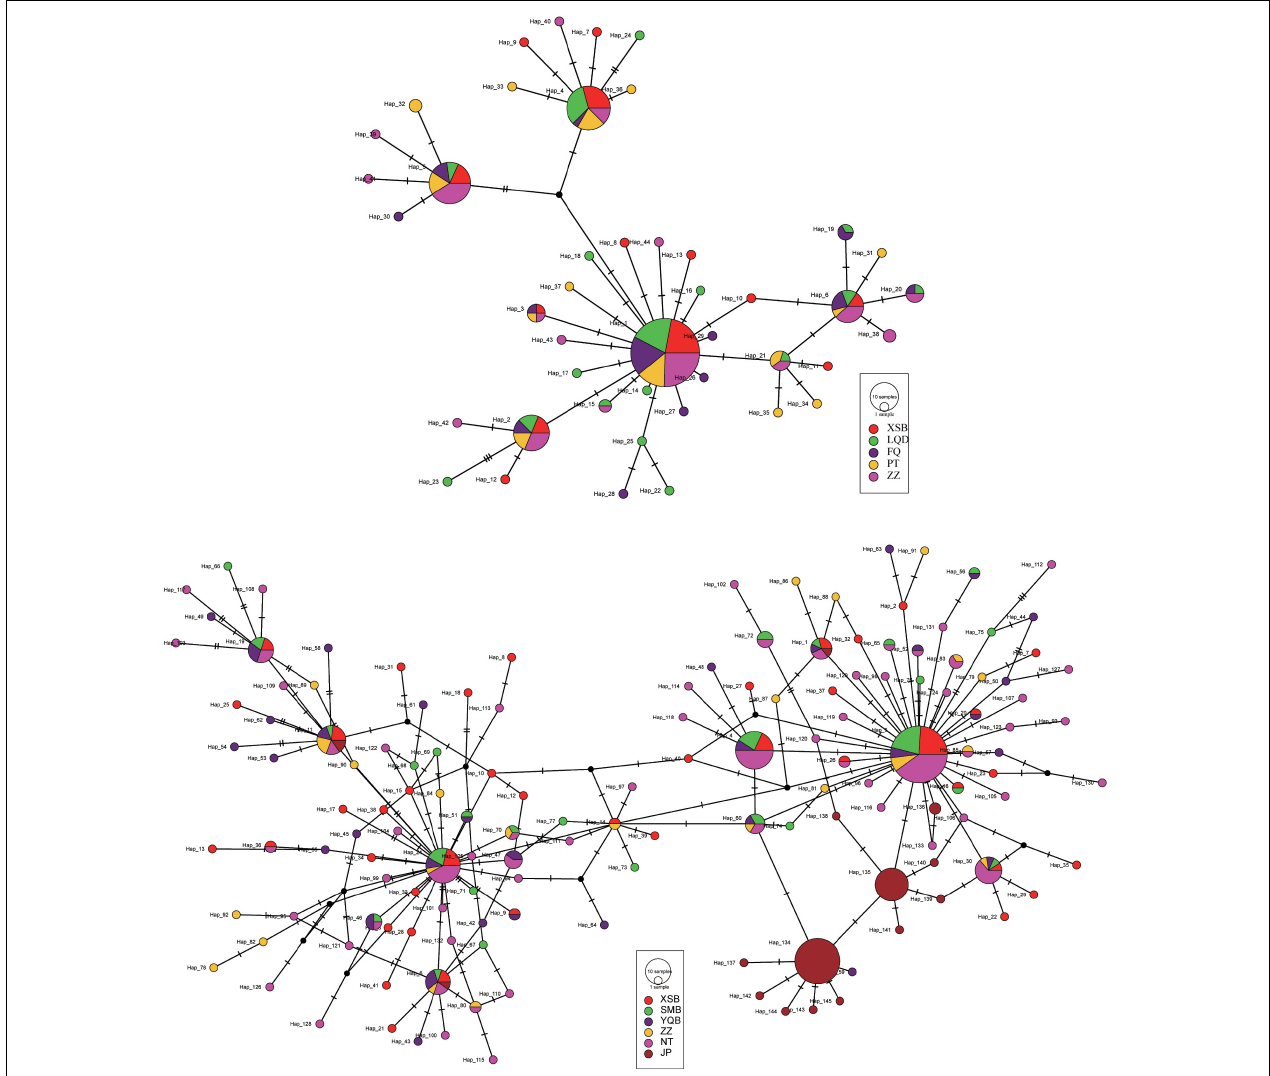
FIGURE 4 | Median joining network for Crassostrea angulata (upper) and C. sikamea (lower) COI haplotypes. The circles represent haplotypes, geographical population samples are marked by distinctive colors, and size of circles are in proportion to the haplotype frequencies. The number of perpendicular bars on branches represents the number of mutations between